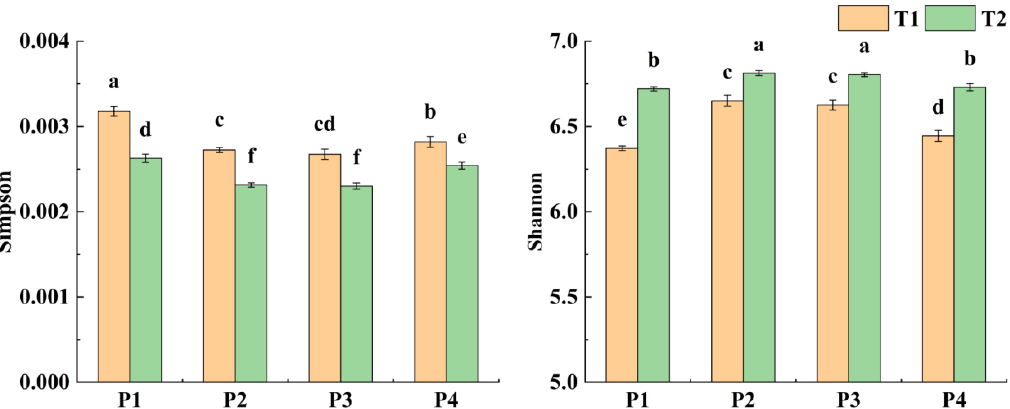
Figure 6. Soil bacterial diversity index under different treatments in 2020. Note T1, no straw return;